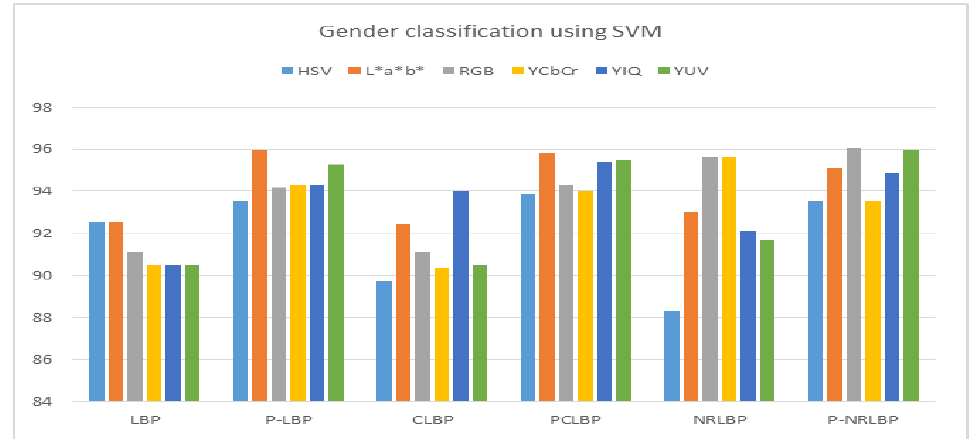
Figure 9. Gender classification using SVM (PICS database).